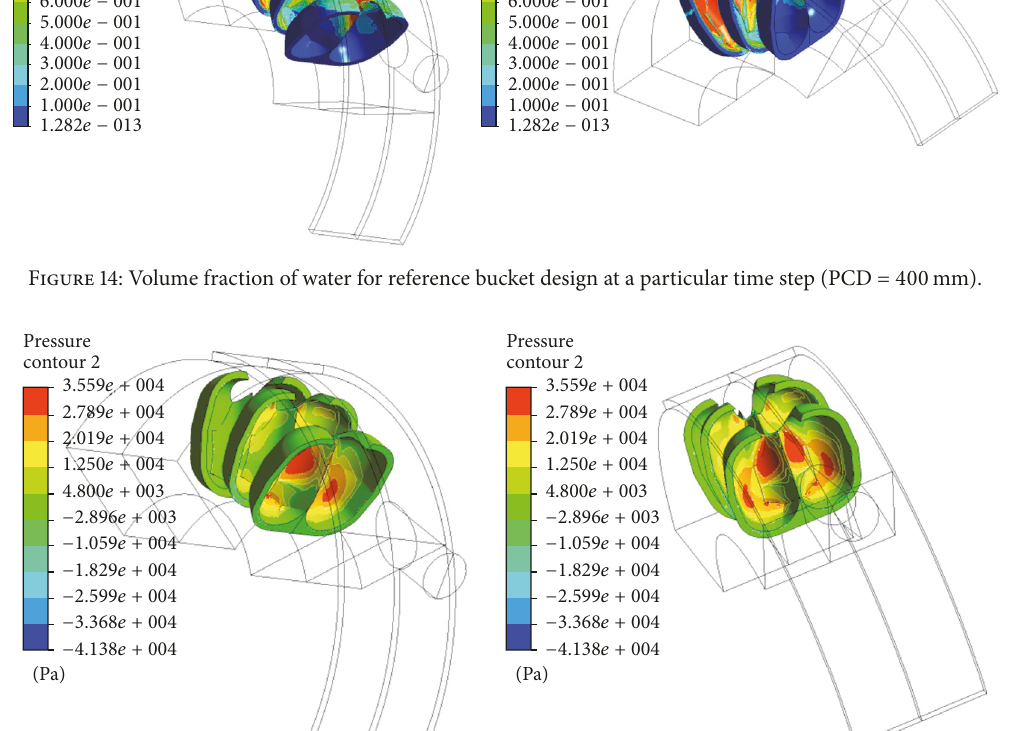
three buckets covered by the water sheets at 0.03 sec of the rotation of the runner. The plot obtained was due to